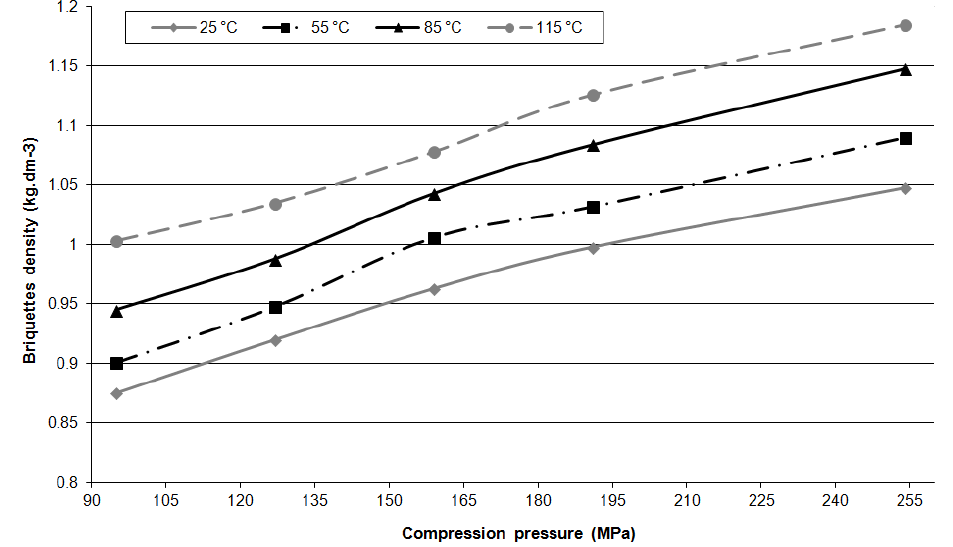
Figure 19. Relation between briquette density and compression pressure at different compression temperatures ( w r = 8%; L = 2 mm)